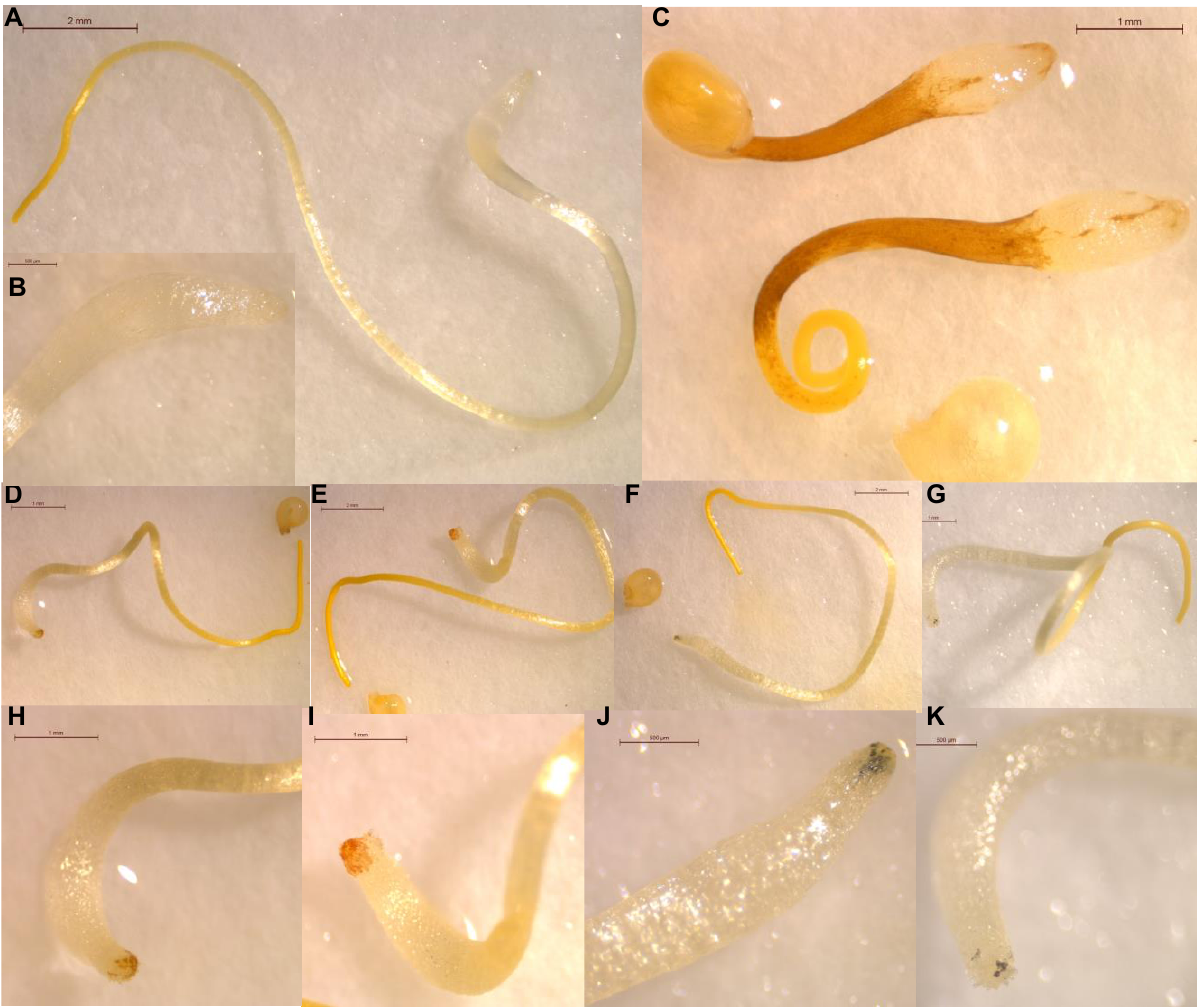
Figure 6. Illustrative photographs showing the necrosis observed in the first screening. ( A ) Cuscuta seedling treated with control ( B ) Detail of Cuscuta root apice treated with control. ( C ) necrosis in the hypocotyl of Cuscuta seedlings treated with pisatin ( 18 ), ( D – K ) necrosis in the root apice in Cuscuta seedlings treated with ( D , H ) caffeic acid ( 8 ); ( E , I ) ferulic acid ( 9 ); ( F , J ) scopoletin ( 10 ) and ( G , K ) sesamol ( 15